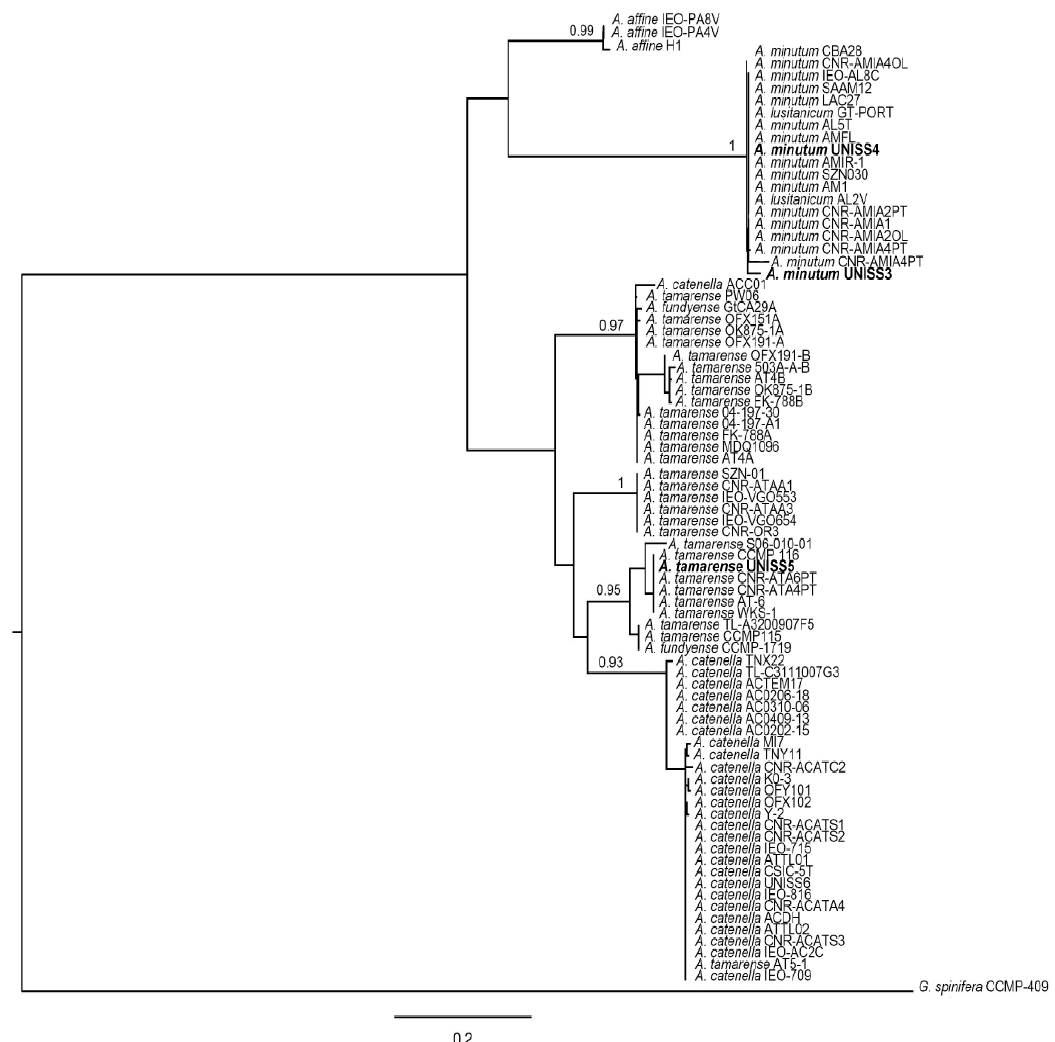
Figure 5. Maximum likelihood (ML) tree of the 5.8-ITS rRNA sequences of selected Alexandrium species (Table S1). Values at the branch nodes indicate ML bootstrap support (BS). Only BS values >50 are shown. The Gonyaulax spinifera sequence was used as an outgroup. The organisms sequenced in this study are shown in bold.